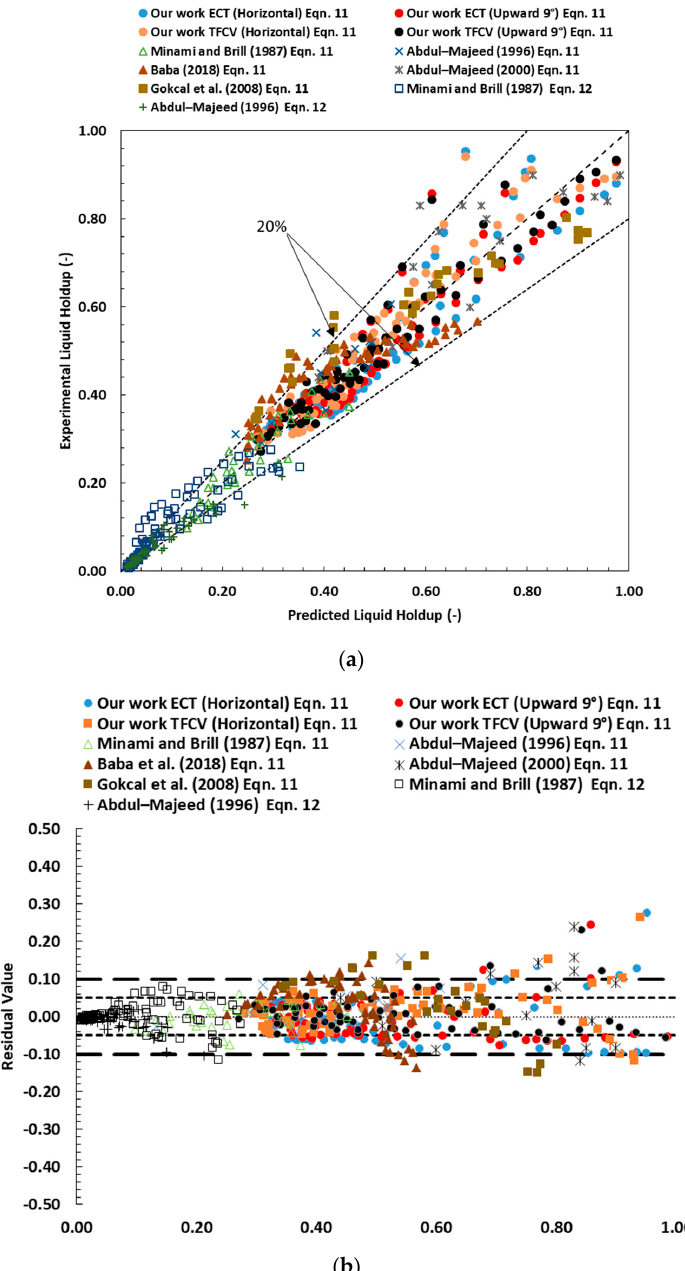
Figure 10. Equations (11) and (12): ( a ) predicted ε (L) against the experimental values, and ( b ) residuals